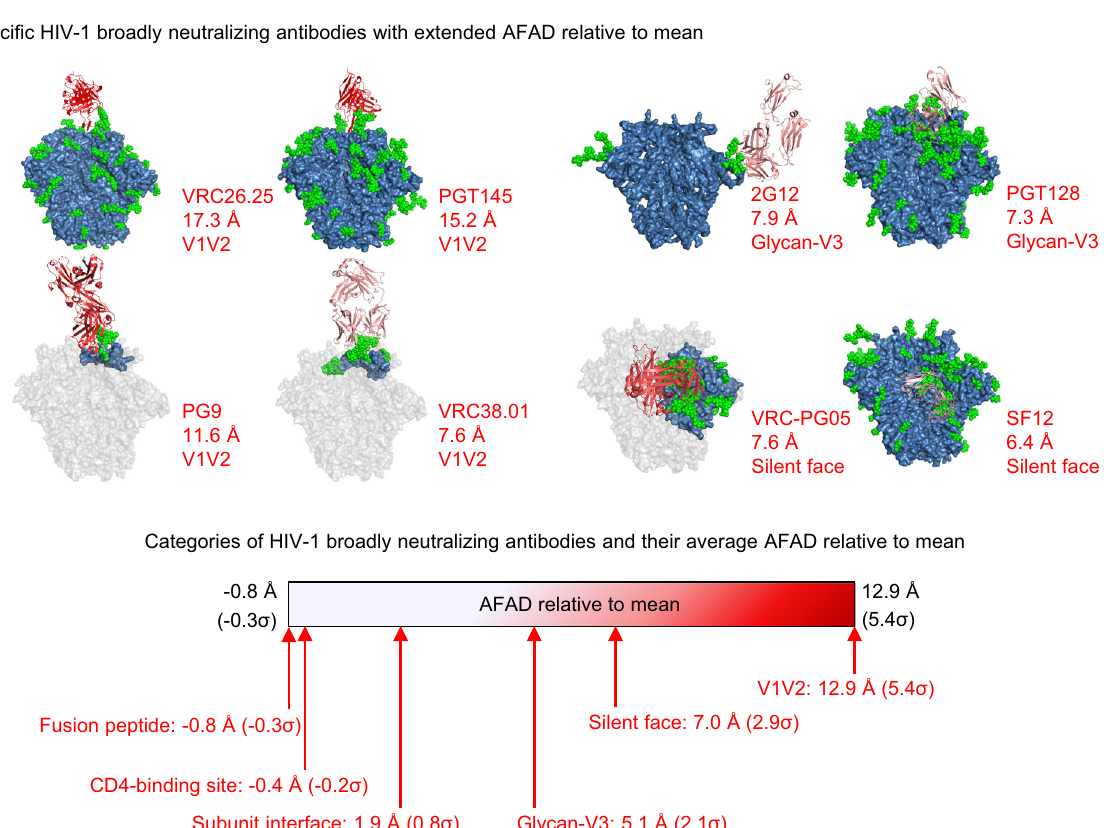
Fig. 2 Only select categories of HIV-1 broadly neutralizing antibodies have extended AFADs relative to mean. HIV-1 broadly neutralizing antibodies, colored according to their AFAD relative to mean and the associated scale is shown at the bottom. Protein surface of Env trimer colored by epitope category (top right). See also Supplementary Table 2. Average AFAD relative to mean for classes of HIV-1 broadly neutralizing antibodies. The antigens are colored in blue if structures are available, otherwise in gray